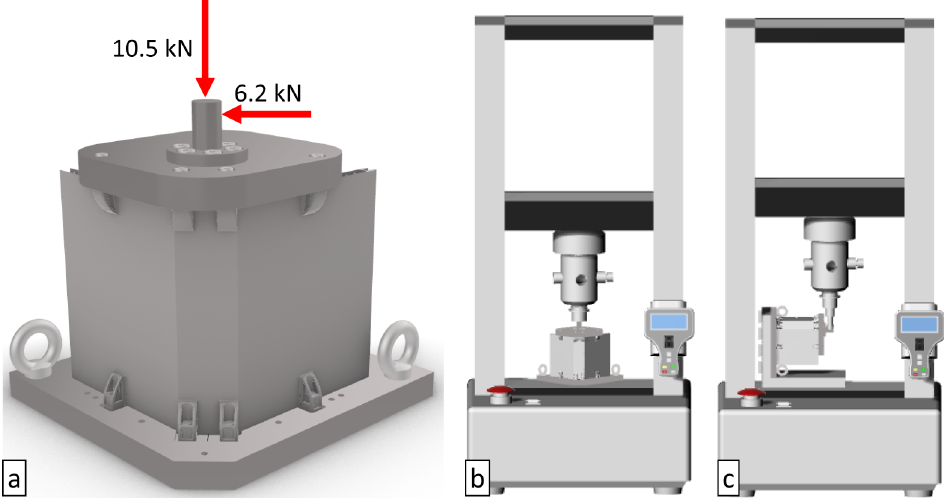
Figure 18. Schematic module assembly for of the static verification system ( a ), compression ( b ) and lateral load ( c ) configuration.